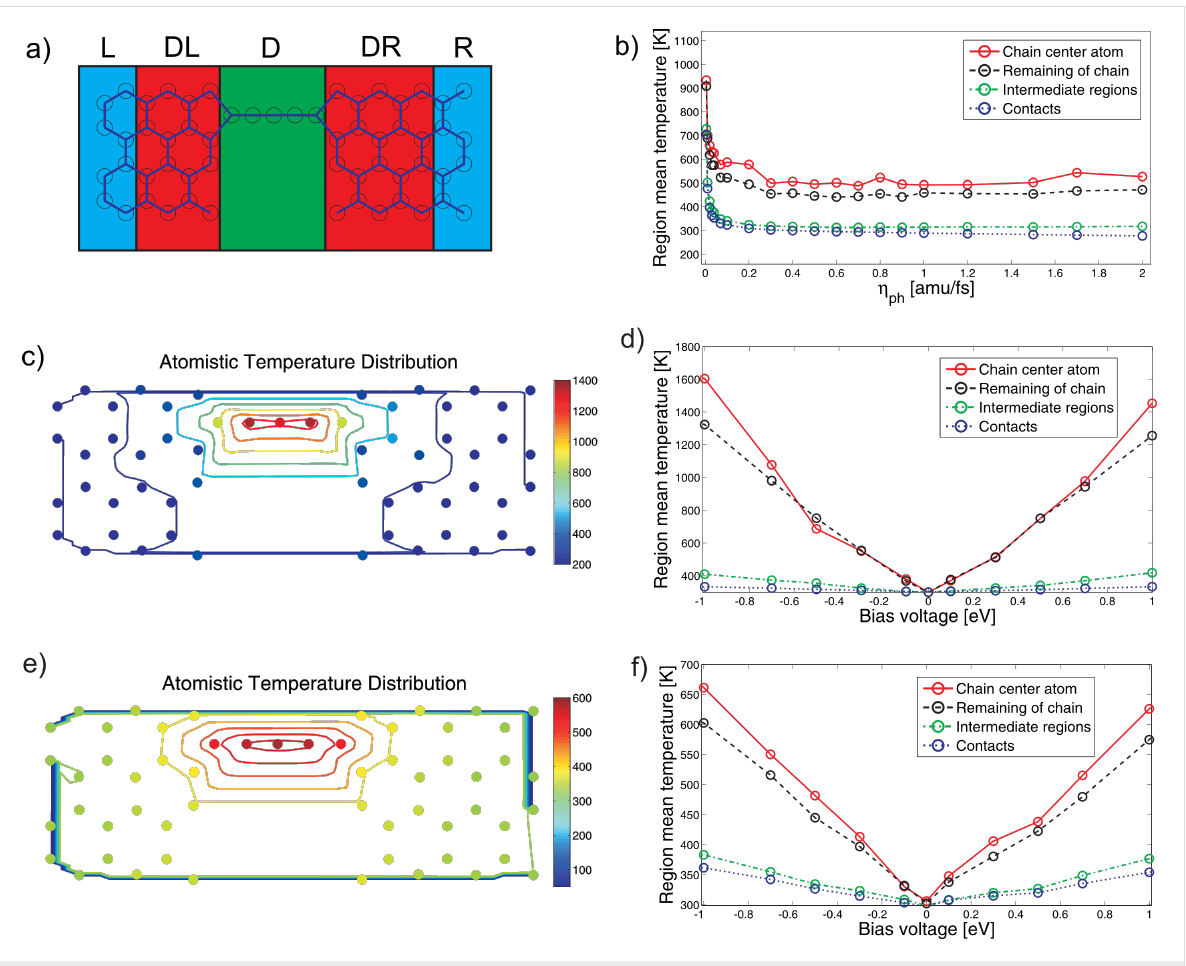
Figure 6: (a) Definition of the system regions with different types of noise contributions. Leads ( L,R ) have a well-defined temperature determined by the phonon noise, the device ( D ) temperature is defined from the electrical heating, and the intermediate regions ( DL,DR ) are free and are heated by propagation noise. In the MD setup no atoms are held fixed, but periodic boundary conditions are applied. The figure describes the setup in which the local temperatures plotted in (c) and (e) should be understood. (b) Temperature of the regions as a function of phonon friction. (c, d) Obtained temperatures at different atoms within the harmonic approximation. (c) The simulations were run at T = 300 K and at eV b = 1 eV, and (d) varying bias voltages. (e, f) Corresponding atomistic temperature distributions including the anharmonic interactions. The lead temperature can exceed the equilib- rium bath temperature due to propagation noise. In particular, the anharmonic interactions redistribute part of the energy from the modes in the chain to the bulk modes in the